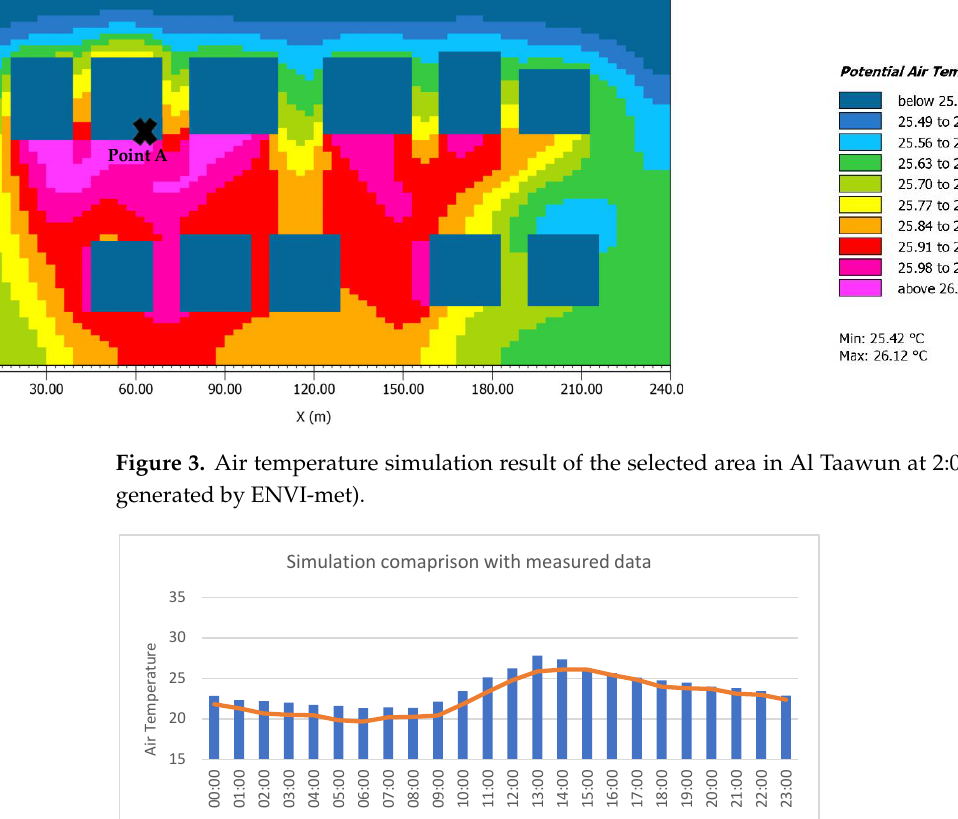
Measured Temp. Ave. °C Simulation Temp. Ave. °C Figure 4. Measured and simulated air temperature in Al Taawun on 11 February 2022.